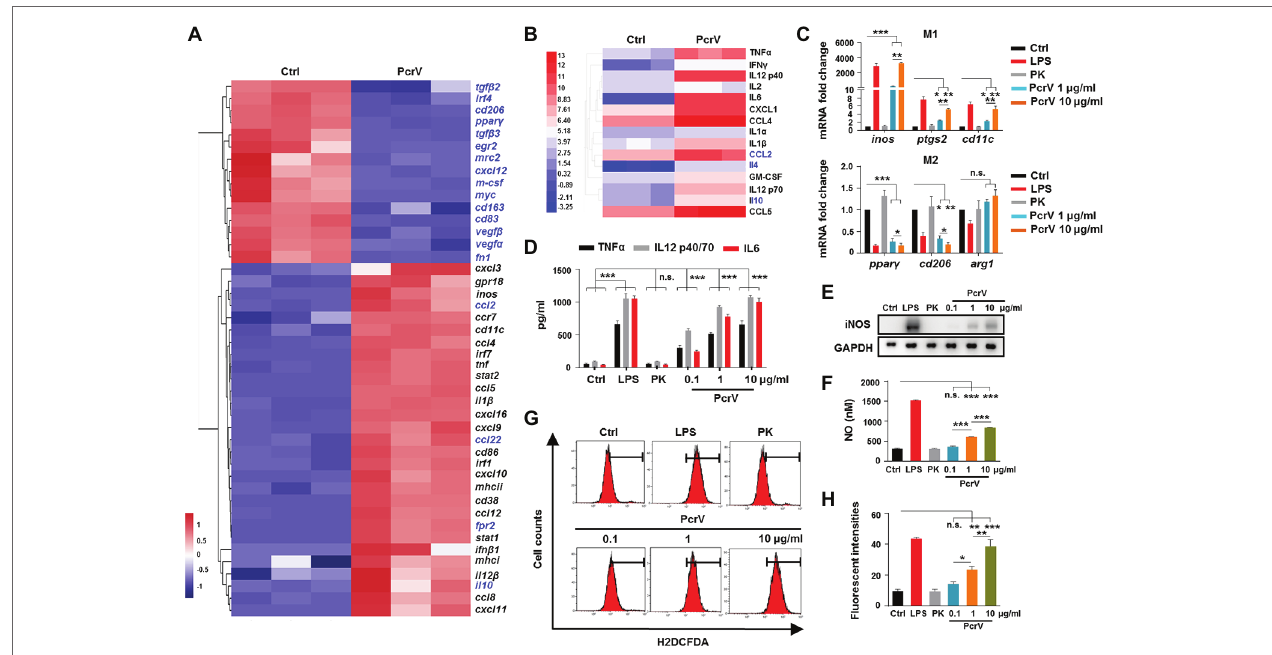
FIGURE 3 | PcrV promotes macrophage M1 polarization. (A) Gene expression and (B) cytokine production in bone marrow-derived macrophages (BMDMs) treated with or without PcrV (10 μ g/ml) for 24 h were analyzed by gene chip and protein chip, respectively. M1-related genes were marked in blank; M2-related genes were marked in blue. (C) Gene expression in BMDMs treated with LPS + IFN γ , hydrolyzed PcrV (PK), and PcrV (10 μ g/ml) for 24 h was verified by RT-qPCR. (D) Levels of TNF α , IL12 p40/70, and interleukin 6 (IL6) in the culture supernatants of the treated BMDMs were assayed by ELISA assay. The production of iNOS (E) and reactive oxygen species (ROS; G,H ) in Raw264.7 treated with LPS + IFN γ , PK, and PcrV for 6 h were detected by western blot and flow cytometry, respectively. (F) The concentration of nitric oxide (NO) in the culture supernatant of Raw264.7 treated with the indicated compound for 24 h was detected by NO detection kit. One-way ANOVA (Tukey’s post hoc , C,D,F,G ) was used for statistical analysis. * p < 0.05; ** p < 0.01; *** p < 0.001; n.s. indicates no significance.